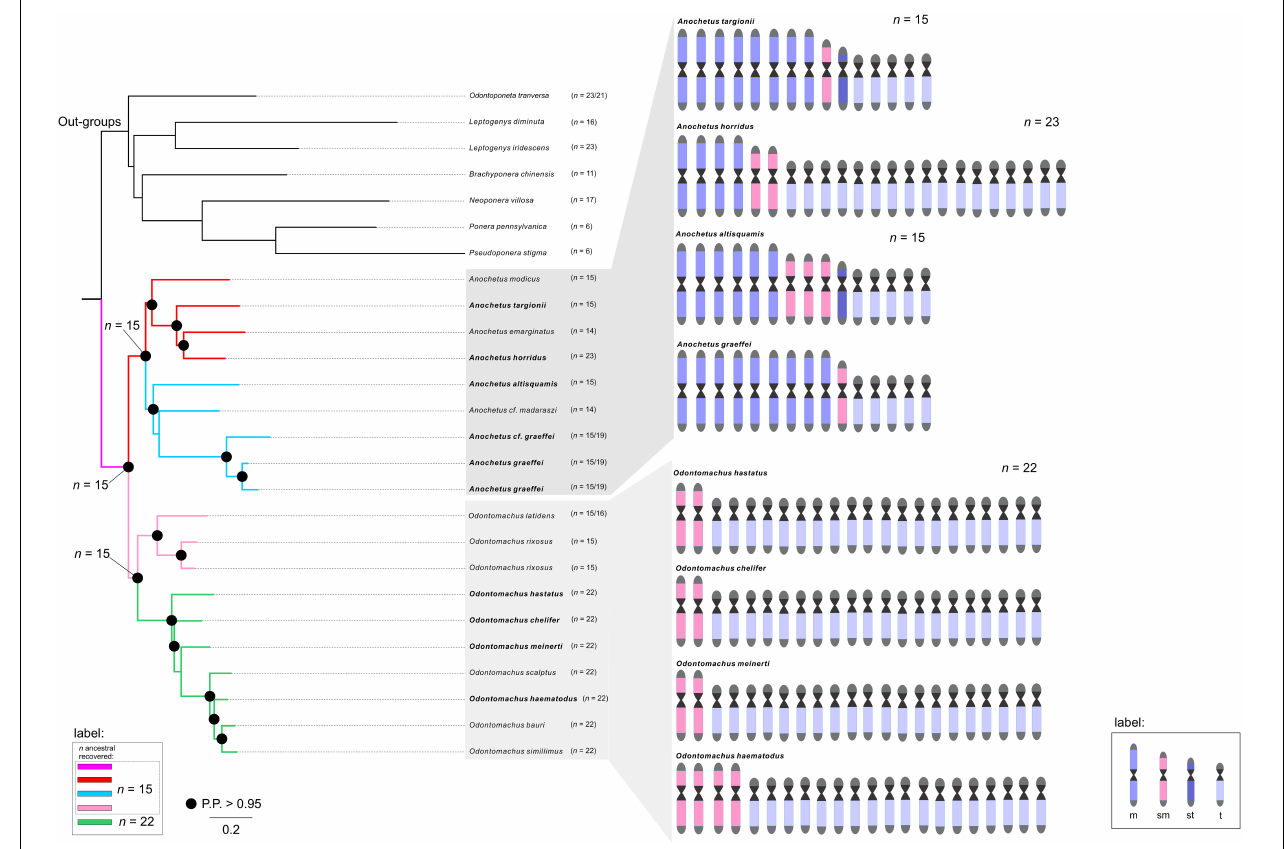
FIGURE 2 | Ancestral haploid chromosome state reconstruction inferred under Bayesian Inference and Maximum Likelihood methods. The ancestral chromosome number with the highest probability or with the best likelihood are denoted at the main nodes. The colors of branches represent each given chromosome number according to the legend. The known karyotypes of species are given at the tip. An ideogram was estimated from the available karyotypic formulae (in bold), denoting the number of metacentric, submetacentric, subtelocentric, and telocentric chromosomes along the